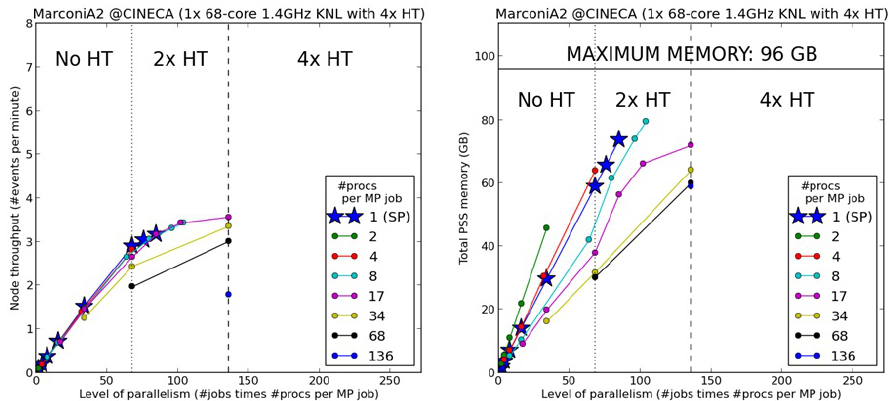
Figure 2. Gauss and GaussMP: throughput and memory on a Marconi-A2 KNL node at CINECA (68 physical cores with 4-way hyper-threading and 96 GB